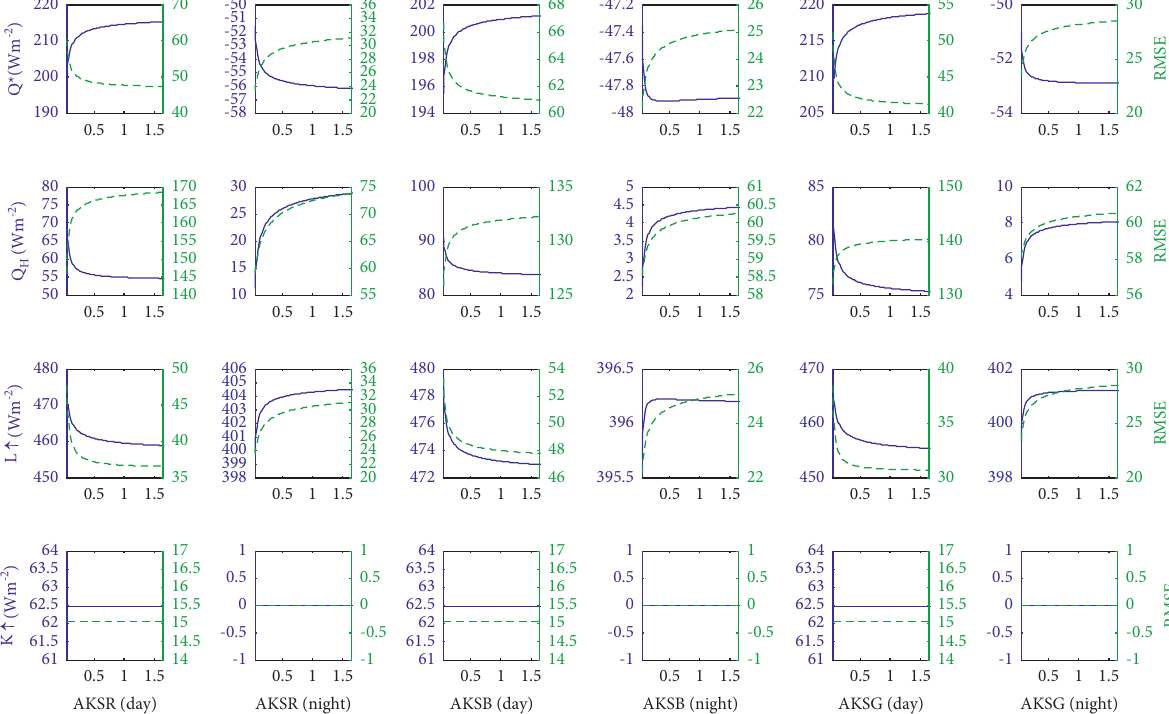
Figure 9: The same as Figure 7, but for conductivity